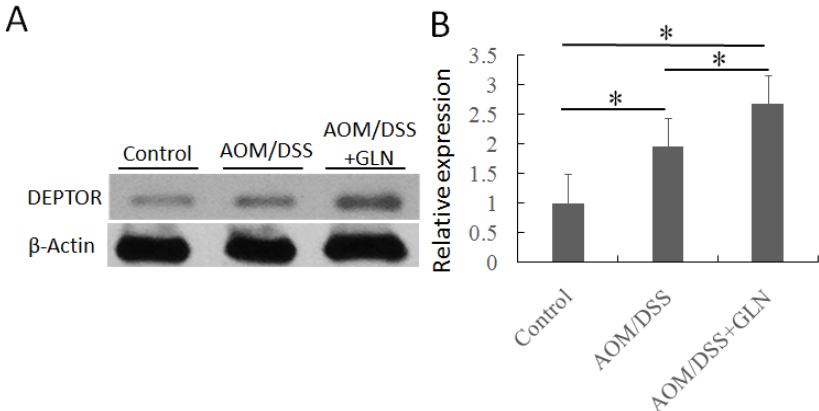
Figure 1. Changes in DEPTOR protein expression in the colon of mice. GLN significantly increased the protein expression in DSS/AOM mice with colitis ‐ associated cancer ( A ). The expression of DEPTOR was statistically analyzed relative to β‐ actin expression by densitometry ( B ). Data are expressed as the means ± SD, * p < 0.05.